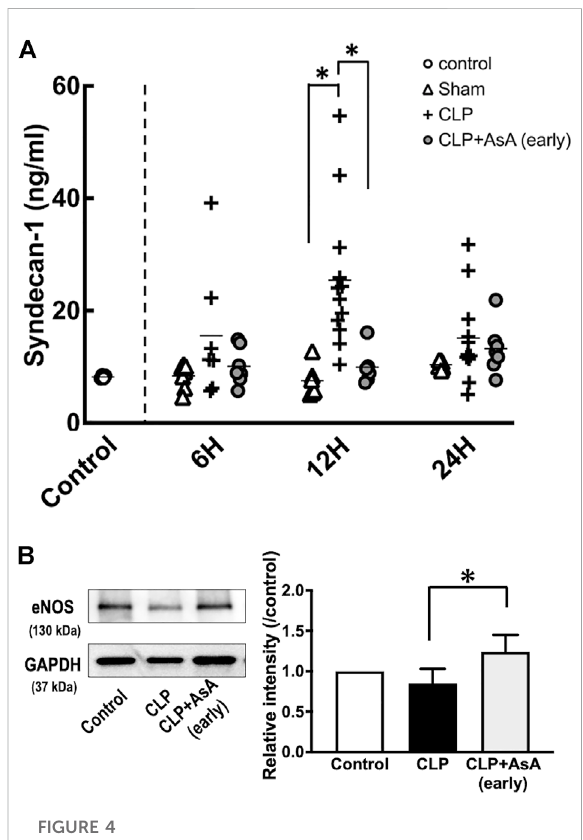
FIGURE 4 (A) Plasma syndecan-1 was measured by ELISA kit. At 12 h after the operation, CLP group had signi fi cantly elevated syndecan-1 level compared to the CLP+ AsA (early) and Sham groups. Error bars represent SE. * p < 0.05. (B) All samples were taken 12 h postoperatively. The expression of eNOS (130 kDa) in the heart was measured by western blotting; it was decreased in the CLP group but maintained in the early AsA group. eNOS was quanti fi ed and compared between the CLP and CLP + AsA (early) groups ( n = 4, 4). For the quantitative experiments, measurements were repeated multiple times. eNOS expression was signi fi cantly maintained in the AsA (early) group. * p < 0.05. Abbreviations: AsA, ascorbic acid; CLP, cecal ligation and puncture; eNOS, endothelial NO synthase; SE, standard